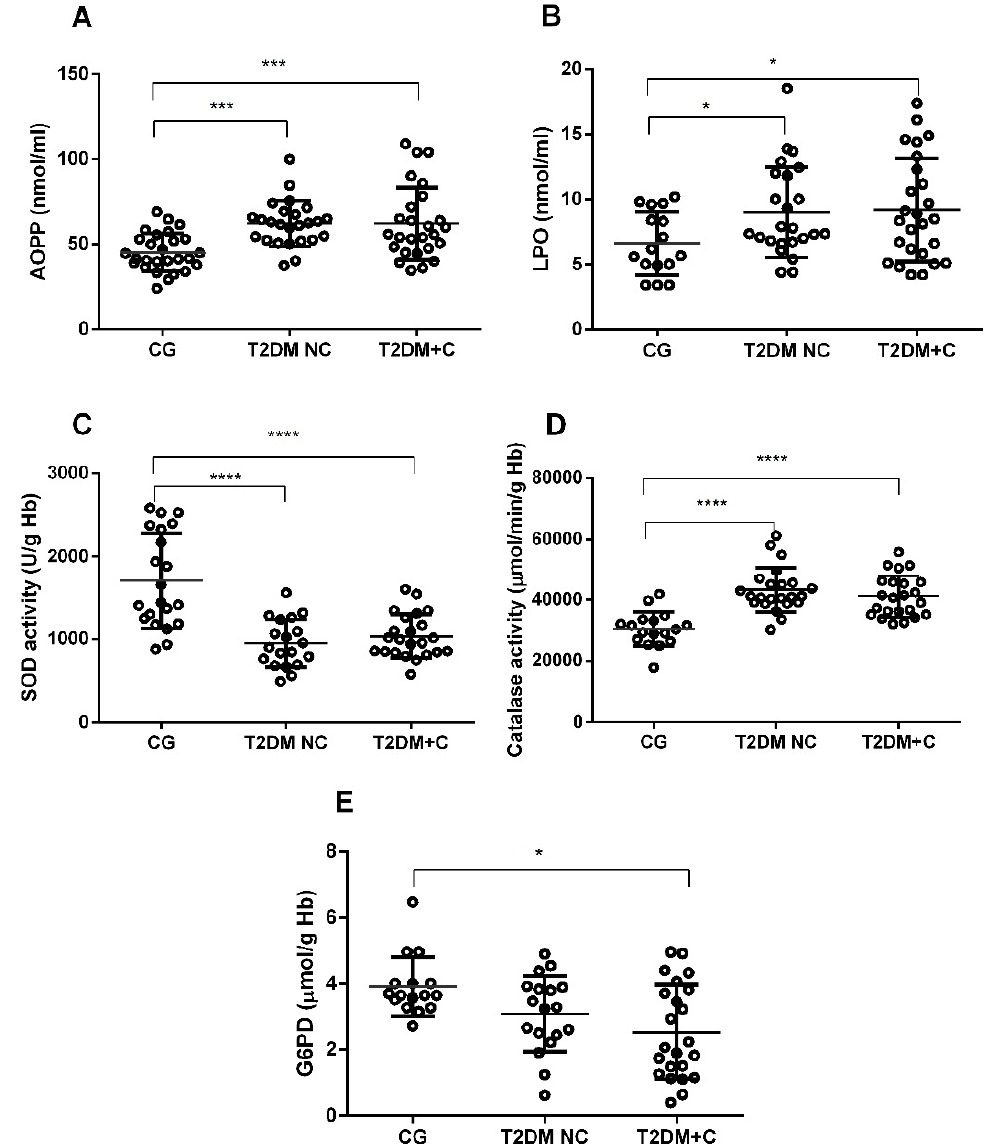
Figure 3. Analysis of oxidative stress parameters in human plasma and erythrocytes of diabetic patients without complications (T2DM NC), with vascular complications (T2DM + C), and controls (CG). ( A ) Advanced oxidation protein products (AOPP) in plasma, ( B ) plasma lipid peroxidation (LPO), ( C ) erythrocyte superoxide dismutase activity (SOD), ( D ) catalase (CAT), and ( E ) glucose-6-phosphate dehydrogenase (G6PD) activity were measured. Comparisons between groups are indicated in the graphs. Data are presented as mean ± SEM. * p < 0.05, *** p < 0.001 and **** p < 0.0001.